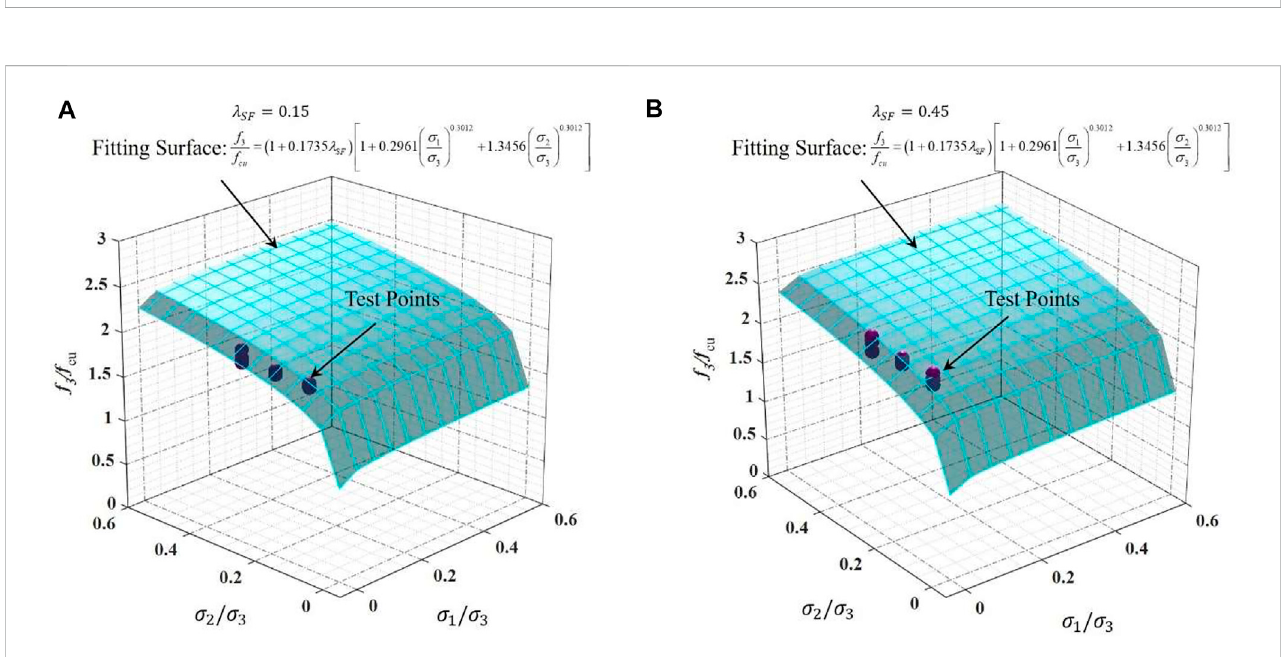
FIGURE 7 Fitting result diagram: (A) λ SF (cid:1) 0 . 15, and (B) λ SF (cid:1) 0 . 45 ( σ 1 / f cu ≤ σ 2 / f cu ).